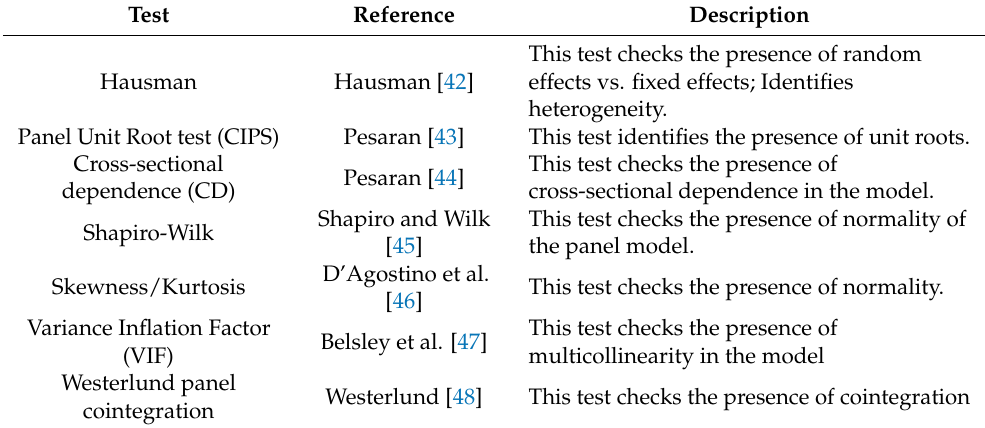
Table 2. Preliminary tests for the fixed effects that are used in this